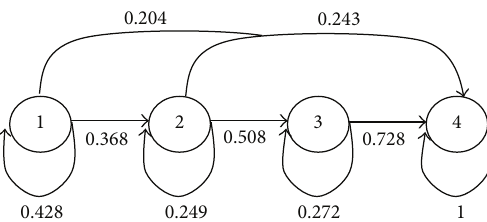
Figure 10: Transition and emission probabilities distribution of cleaning activity of trained HMM based on left-to-right HMM